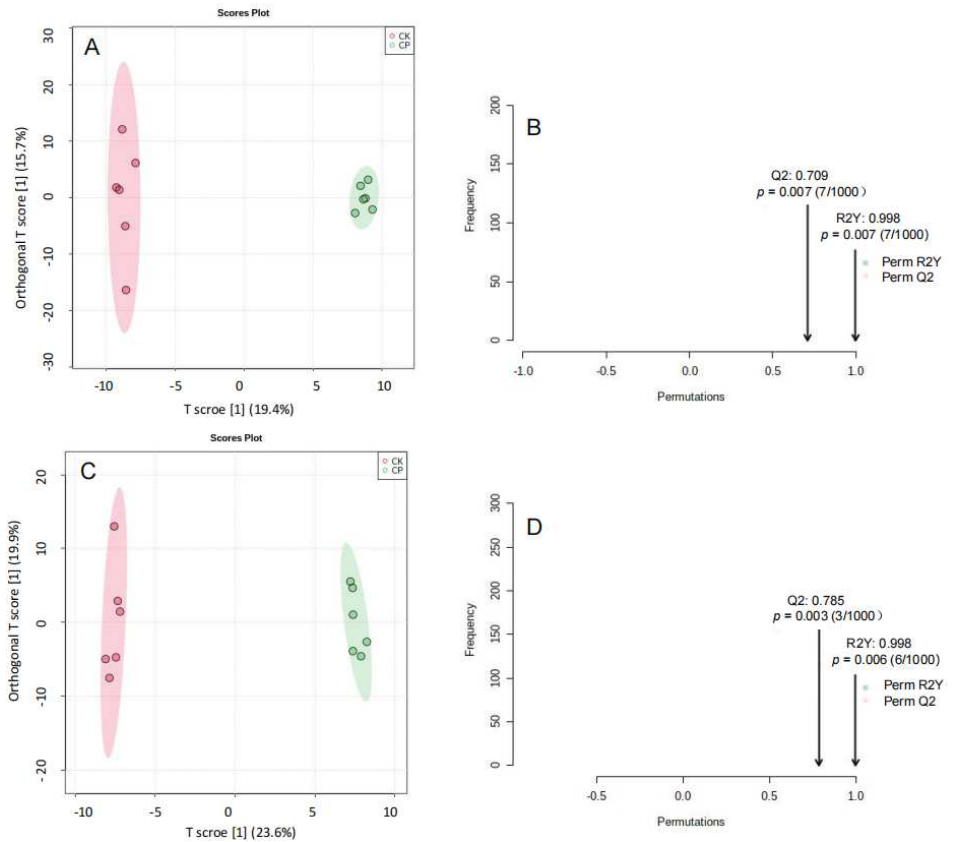
Figure 4. OPLS-DA score plots of amniotic fluid lipid profile and validation of OPLS-DA models in the CP and CK groups using permutation tests ( n = 6). ( A , B ) Positive ion mode; ( C , D ) negative ion